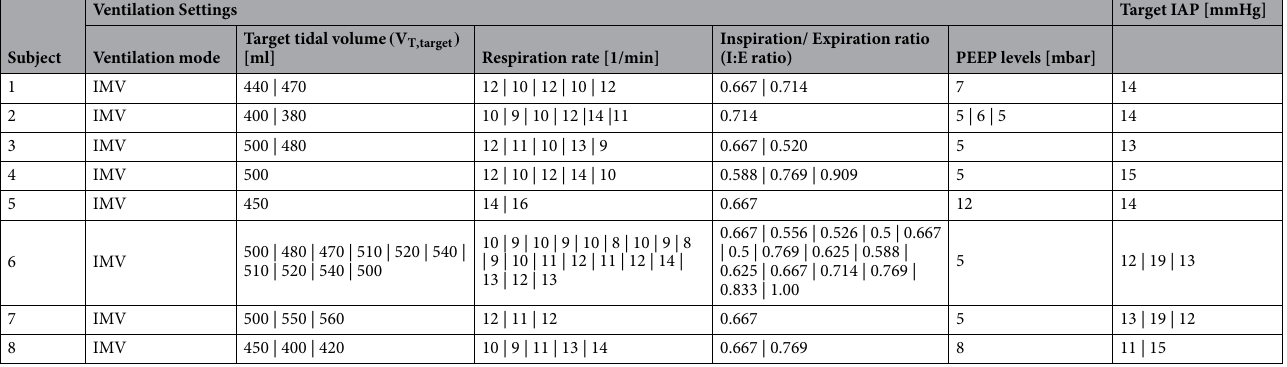
Table 5. Ventilation settings and target IAP for volume-controlled ventilated patients. IMV refers to intermittent mandatory ventilation mode (a VCV